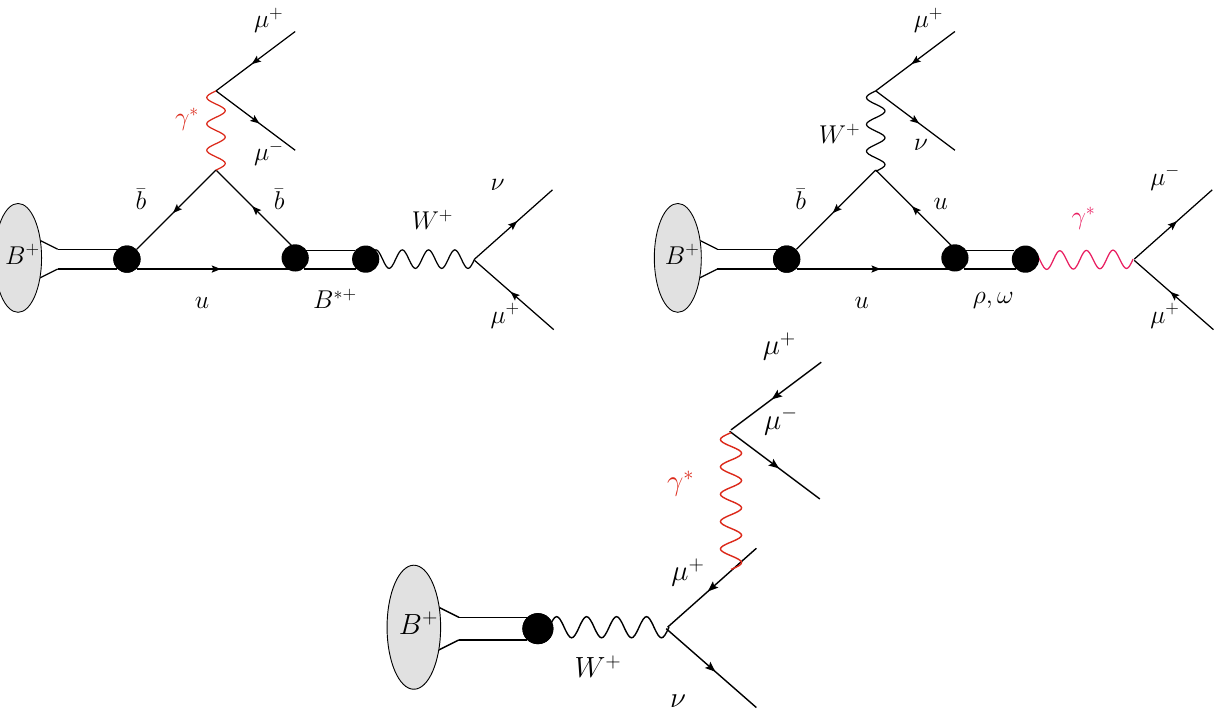
Fig. 1 Feynman diagrams of the contributions (top left) B + → μ + ν μ γ ∗ with γ ∗ → μ + μ − , (top right) B + → μ + ν μ V and (bottom) bremsstrahlung to the B + → μ + μ − μ + ν μ